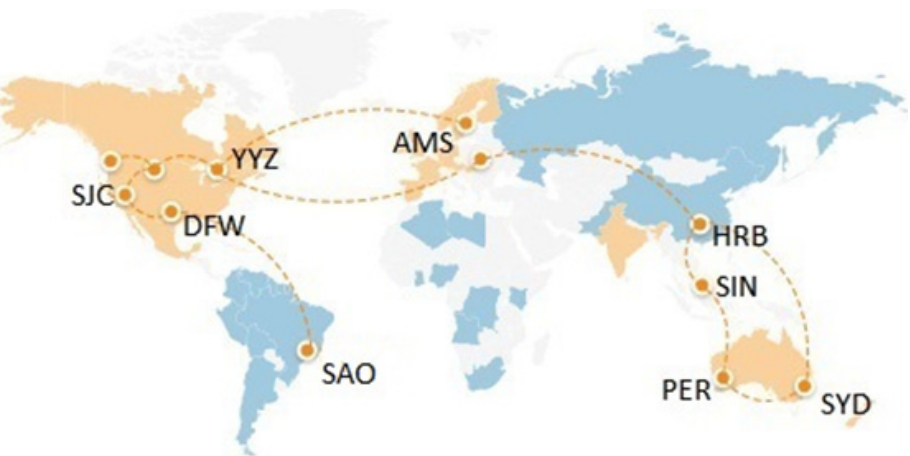
Figure 1. Typical globally distributed cloud computing (GCC) infrastructure and data flows.